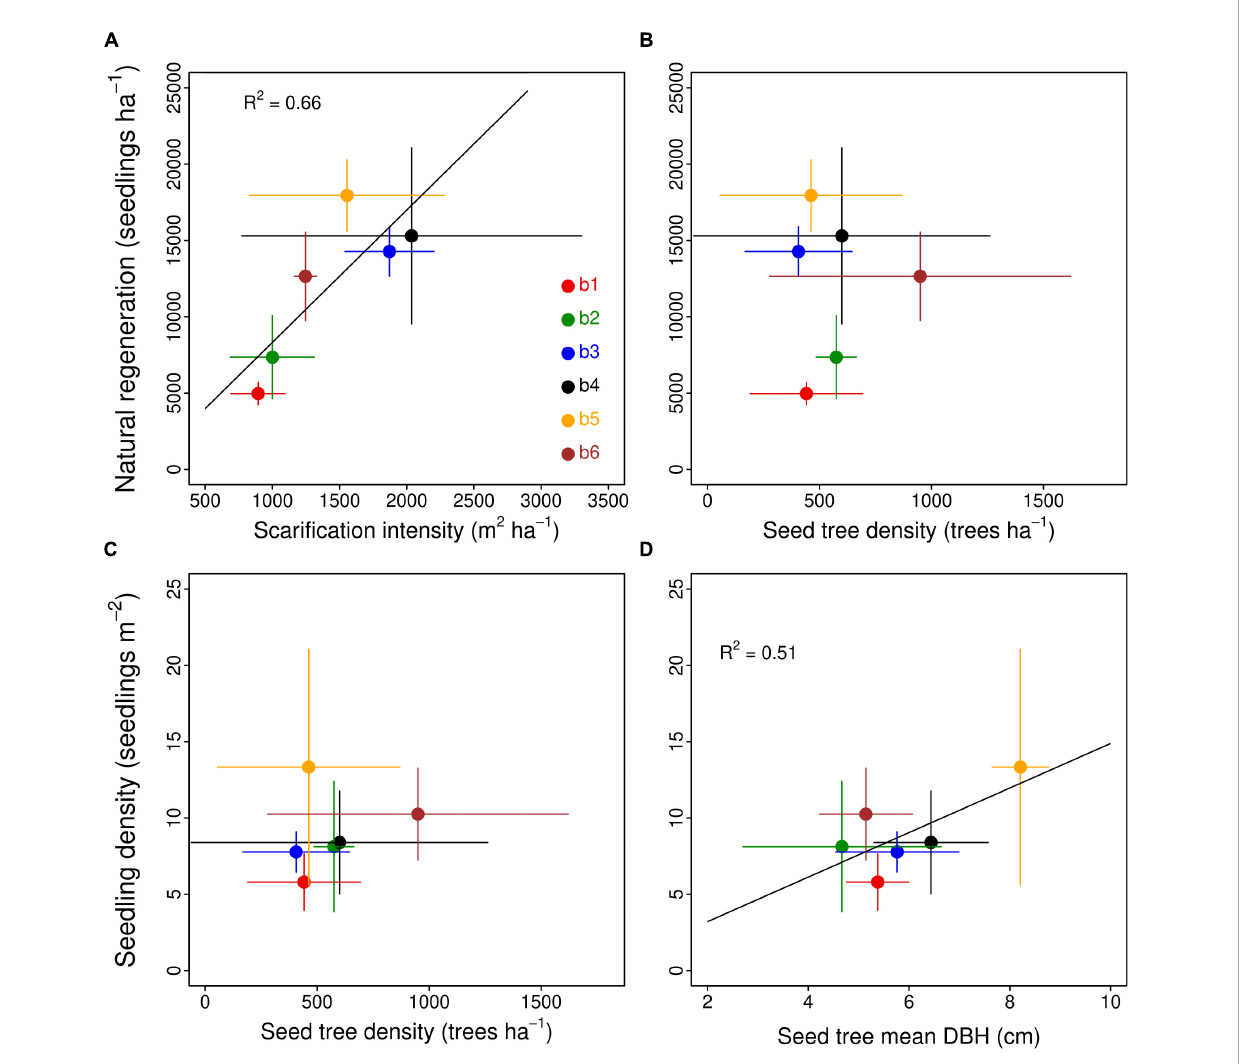
FIGURE2 Top panels. Relationships between natural regeneration density (seedlings ha − 1 ) and (A) the surface area of exposed mineral soil (m 2 ha − 1 ); and (B) seed tree density (trees ha - 1 ). The equation of the linear regression in panel (A) is y = 4672 + 4.8 x. Bottom panels. Relationship between seedling density (per m 2 of exposed mineral soil) and (C) seed tree density (trees ha - 1 ); and (D) seed tree mean DBH (cm). The equation of the linear regression in panel (B) is y = 0.71 + 1.35 x.